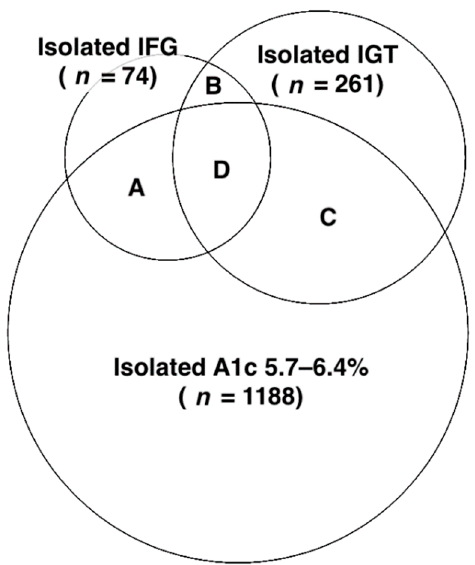
Figure 2. Venn diagram representing different domains and agreements of prediabetes categorized by glycated hemoglobin A1c (A1c) 5.7–6.4%, impaired fasting glucose (IFG), and impaired glucose